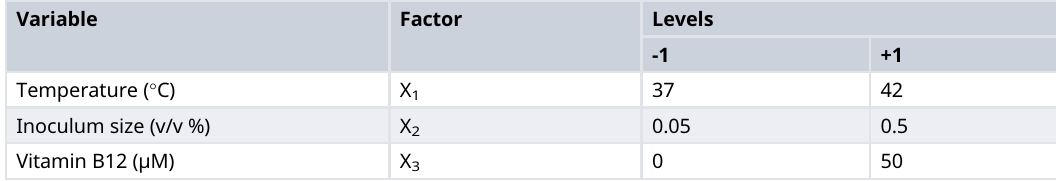
Table 2. The coded and uncoded variables for screening the growth behavior in bacterial cultures.